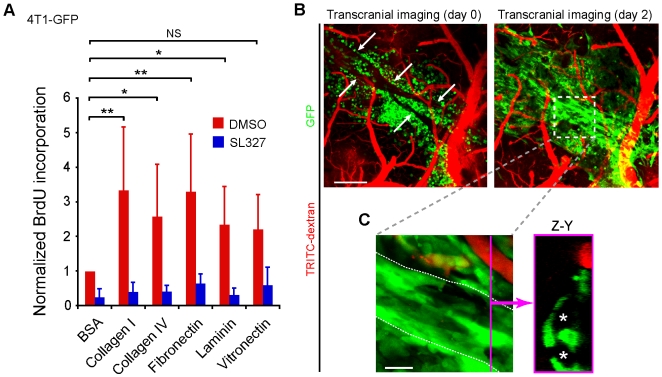
Brain vascular basement membrane potentiates carcinoma growth.(A) Basement membrane components (as indicated) potentiate incorporation of BrdU in 4T1-GFP cells in the absence of serum in vitro (*P<0.05, **P<0.001; ANOVA with Bonferroni Multiple Comparisons Test, experiment in triplicate, 3 repeats). BrdU incorporation was attenuated by treatment with the selective MEK inhibitor SL327 (all post-drug differences significant to P<0.01 except BSA). Error bars represent s.d. (B) After intraparenchymal injection of 4T1-GFP cells, several isolated meningeal vessels were placed over the injected tumor cells. The 4T1-GFP cells grew on the basement membrane of these non-perfused microvessels (outlined by arrows, left) in vivo. Growth was monitored with serial transcranial imaging; day 0 (left), day 2 (right). Scale bars, 240 µm. (C) Detail of hatched region in (B) demonstrating growth upon non-perfused vessels (hatched white lines). Reconstructed Z-Y dimension image at the level of the magenta line (right) demonstrates former lumens (asterisks) of the non-perfused vessels now surrounded by tumor cells. Scale bars, 30 µm (bottom).